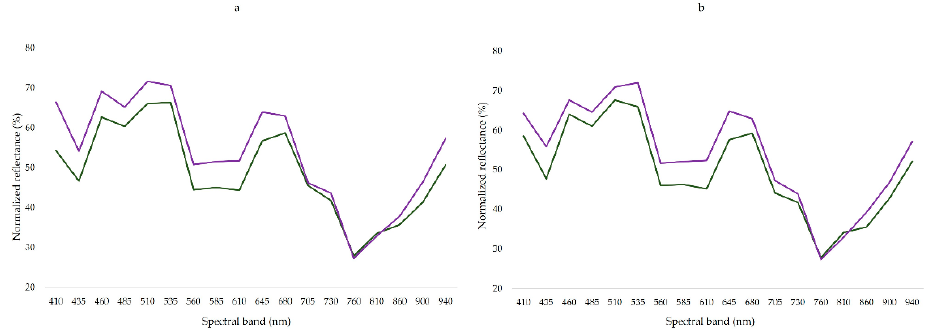
Figure 7. Mean reflectance responses of grape clusters with an advanced ripening state (purple) and an initial state (green) relating their levels of SSC ( a ) and TA ( b ). Each line includes the mean reflectance of eight samples (corresponding to approximately the 10 th and above the 90 th percentile, respectively, for each parameter).